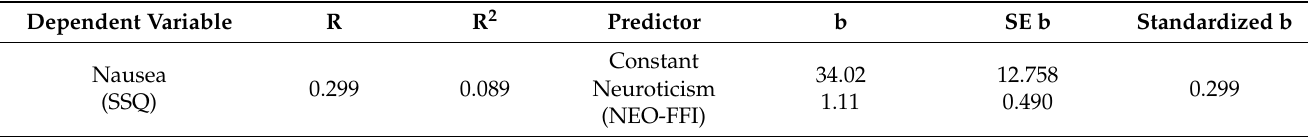
Table 5. Results of the regression analyses for the dependent